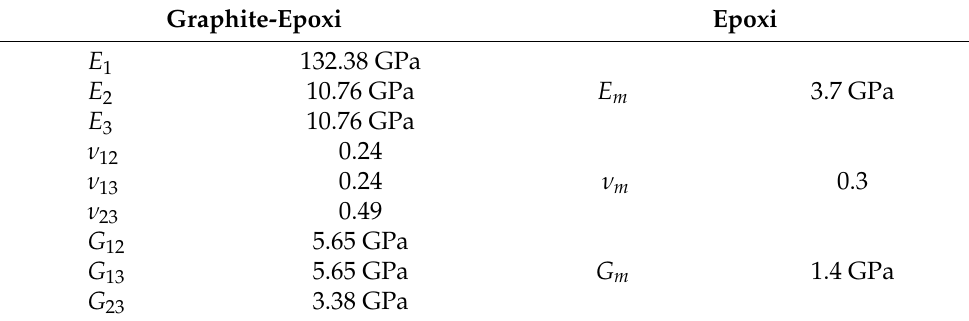
Table 2. Material properties.